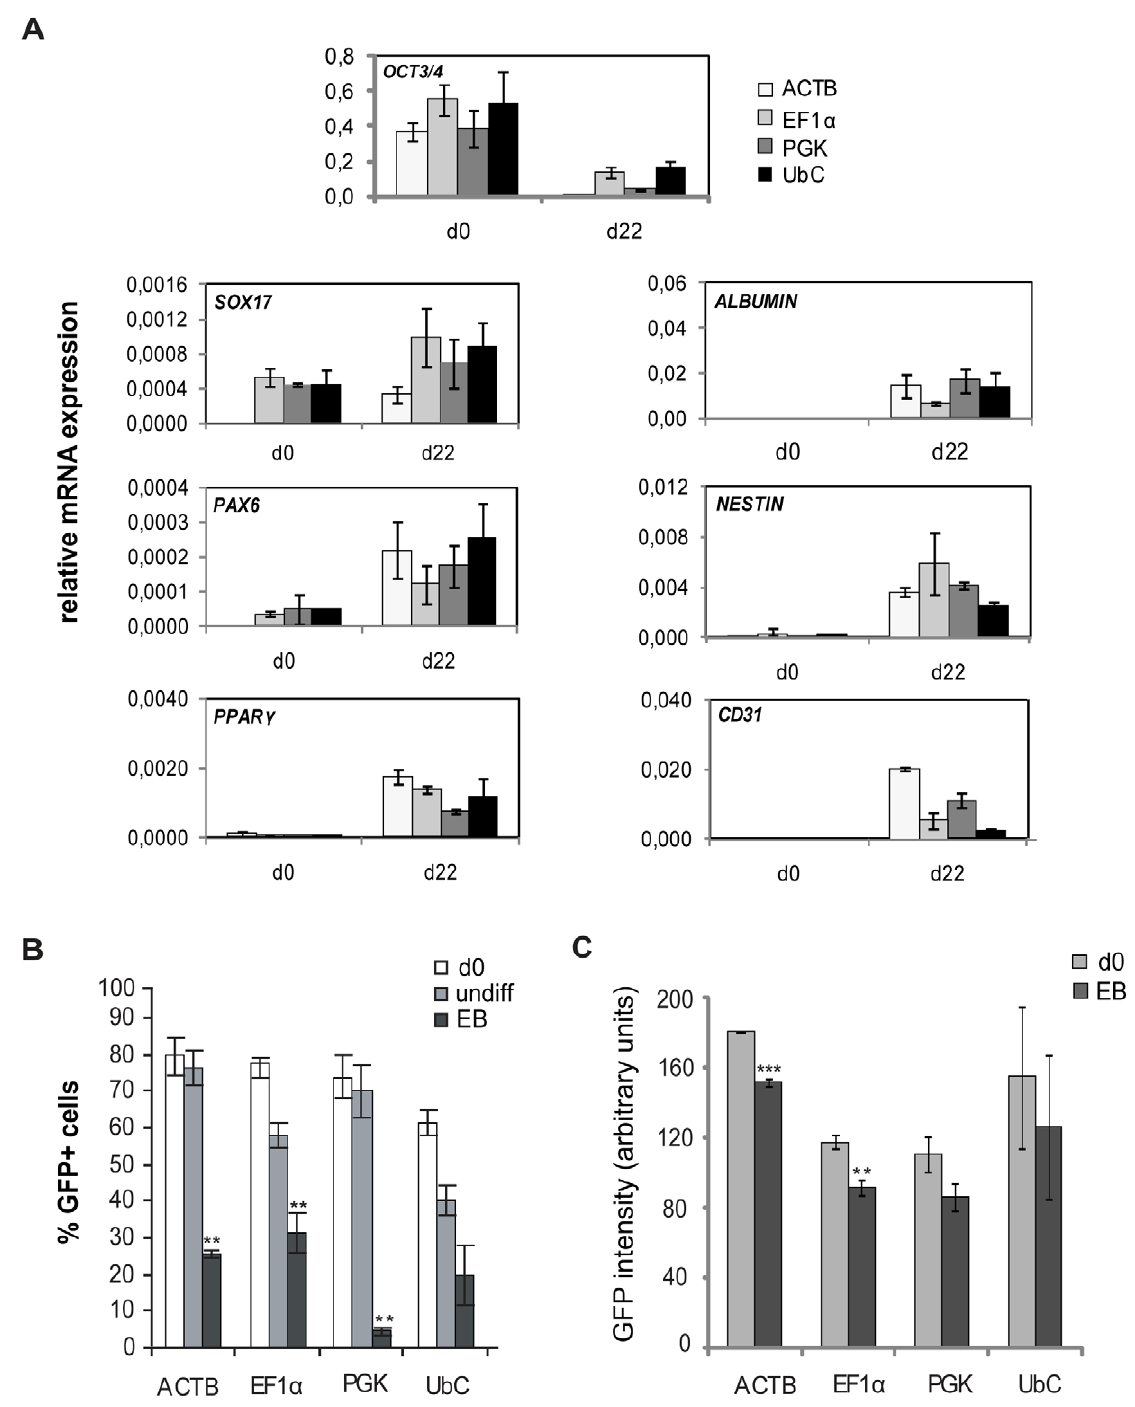
Figure 3. Promoter activity during differentiation of hESCs. A. Gene expression analysis of undifferentiated ACTB-, CMV-, EF1 a -, PGK- or UbC- eGFP transduced hESCs and after EB differentiation, plotted as relative to reference gene GAPDH. SOX17, ALBUMIN, PAX6, NESTIN, PPAR c and, CD31 were used as marker genes for endodermal, ectodermal and mesodermal cell lineages and OCT3/4 as pluripotency marker. Results in A–C are plotted as mean of three independent experiments and error bars indicate 6 s.d, B . hESC line SA121 was differentiated as embryonic bodies for 22 days and promoter activities in ACTB-, CMV-, EF1 a -, PGK- or UbC-eGFP transduced cells were measured by FACS analysis as % eGFP + cells. In parallel, % eGFP + cells were measured on ACTB-, CMV-, EF1 a -, PGK- or UbC-eGFP transduced cells that were maintained in their undifferentiated state for 22 days. Statistical analysis of EB day 22 as compared to undifferentiated day 22 (**p # 0.0039 students t’test). C. Average level of intensity of eGFP fluorescent signal of the eGFP + population, detected by FACS analysis at start of differentiation, day 0 and after 22 days, measured as average mean fluorescence intensity. Statistical analysis of EB d22 as compared to undifferentiated cells day 0 (**p , 0.001,***p , 0.0001 students t’test).